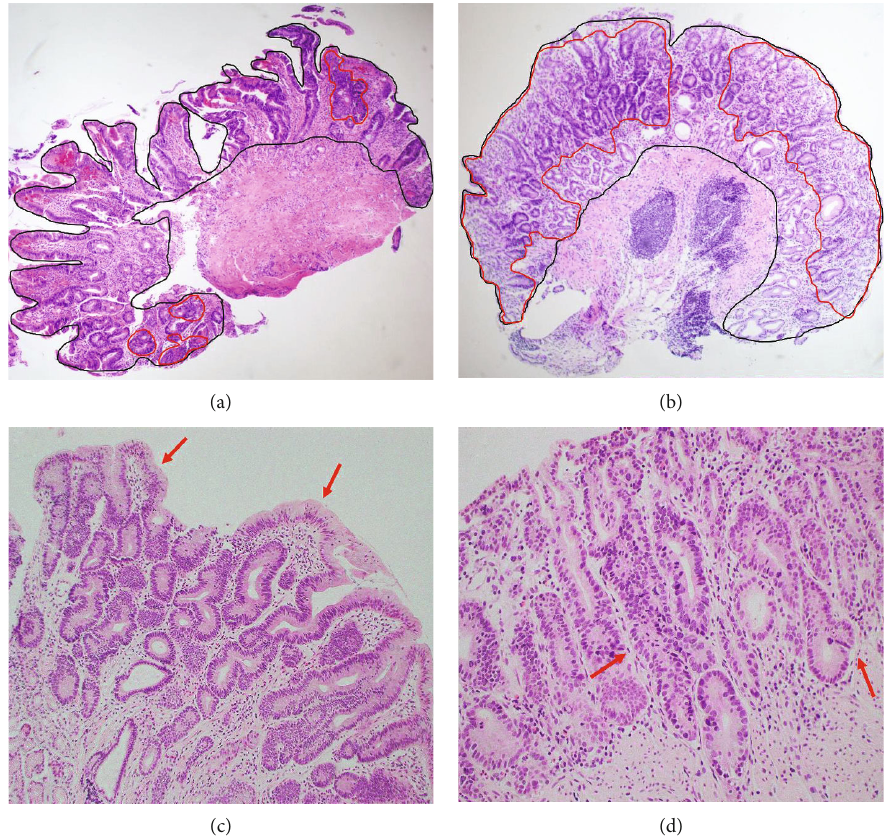
Figure 1: Representative images of structural atypia area (red-lined inner area) and area with total inde fi nite for dysplasia (black-lined inner area) In the red-lined inner area, one or more of the following are seen: variable glandular size, irregular glandular arrangement, glandular branching/budding, and glandular cribriform. In the black-lined inner area, one or more of structural or nuclear atypia are visible. (a) Structural atypia was present in 6.18% of the area, with a fi nal diagnosis of nonneoplasm (hematoxylin and eosin; × 40 magni fi cation). (b) The area ratio of the structural atypia was 61.1%, with a fi nal diagnosis of carcinoma (hematoxylin and eosin; × 40 magni fi cation). (c) A representative image of an area of nuclear atypia without structural atypia. Loss of surface maturation (arrow), nuclear enlargements, and hyperchromasia are visible (hematoxylin and eosin; × 100 magni fi cation). (d) A representative image of an area of structural atypia. Glandular variation in size, irregular arrangement, and branching/budding (arrow) are visible (hematoxylin and eosin; × 200 magni fi